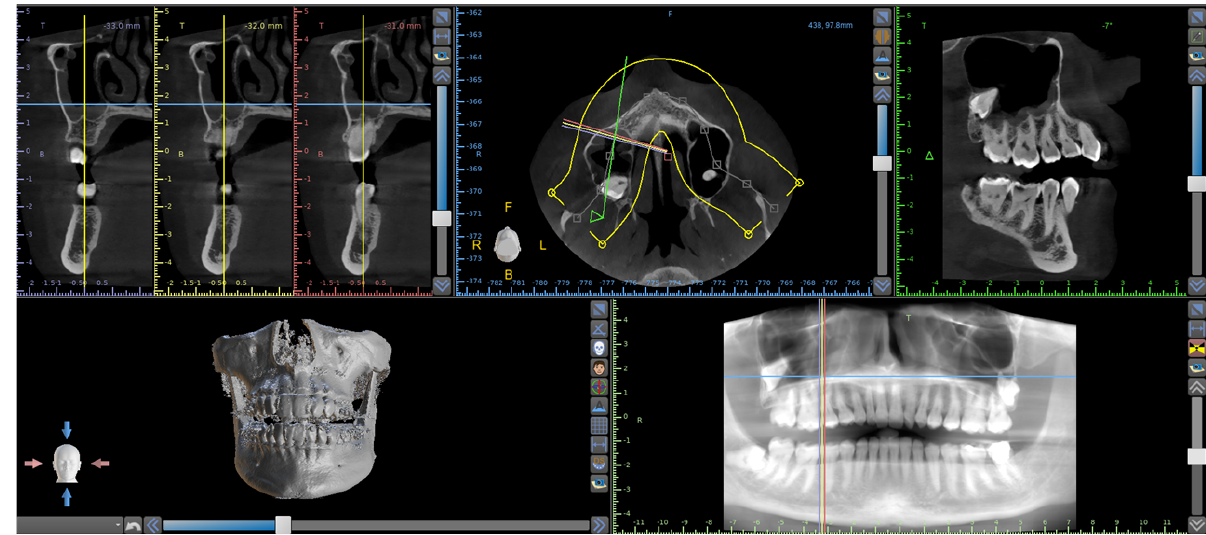
Figure 1. Impacted symptomatic 18 on OPG.